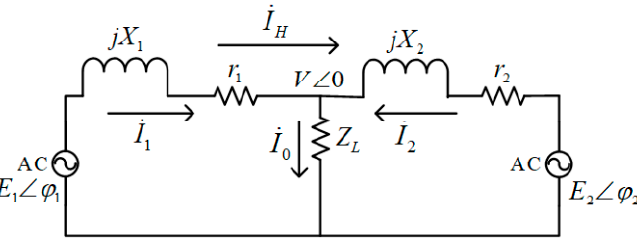
Figure 5. Simplified model diagram of auxiliary converter parallel system.